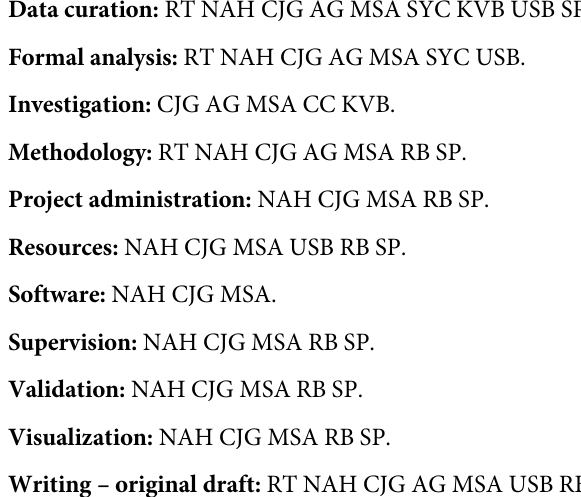
S3 Table. Identification of gaps or genetic differences in Salmonella